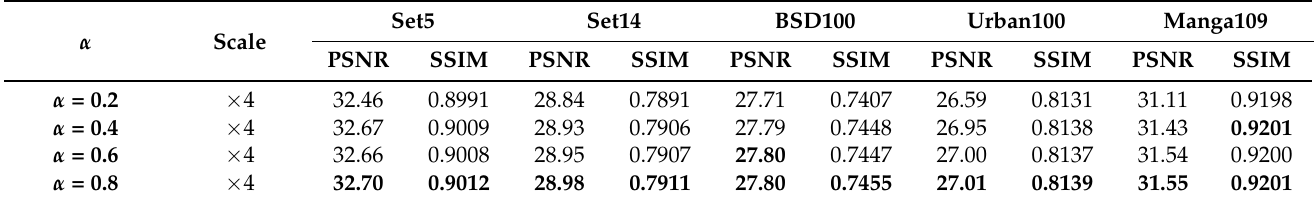
Table 5. Quantitative performance comparison among different objective functions at × 4 scale.